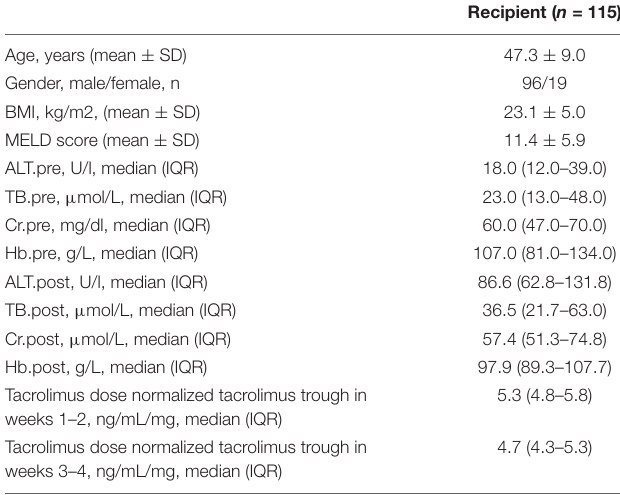
TABLE 1 | Characteristic of